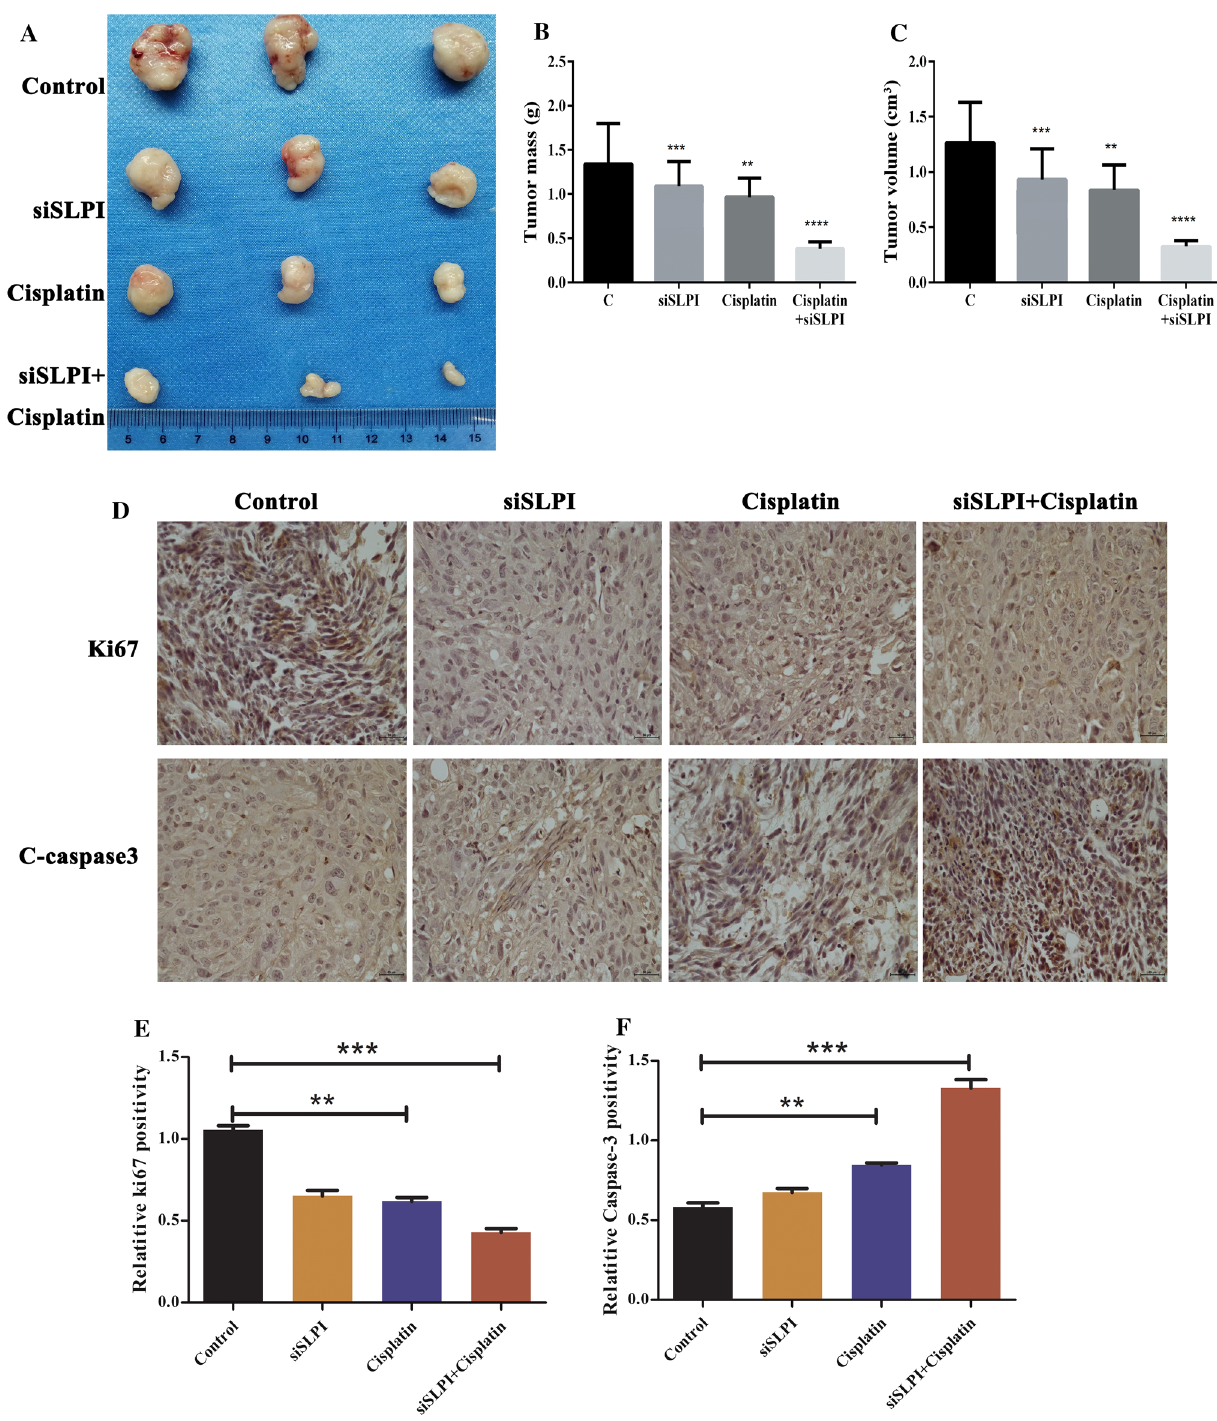
Fig. 5 In vivo Effects of siSLPI and cisplatin tumor growth. The tumor sizes in the Cisplatin + siSLPI group was smaller than that in the Cispl- atin + siSLPI groups ( A ). The combined treatment with Cisplatin + siSLPI displayed the lowest tumor weight ( B ). The tumor volume of Cispl- atin plus siSLPI is considerably reduced ( C ). Immunohistochemical results showed that Ki67 level was downregulated while the c-caspase3 level was upregulated in the Cisplatin + siSLPI group ( D – F ) *p < 0.05; **p < 0.1, and ****p <